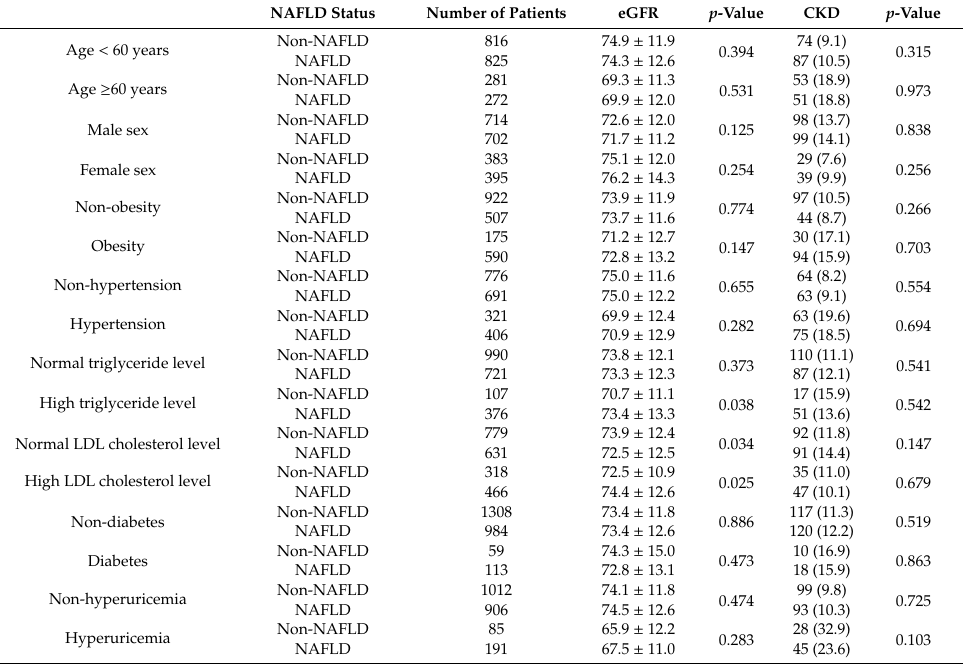
Table 3. Comparison of the eGFR and prevalence of CKD in subjects with and without NAFLD in the subgroup analyses after propensity score matching.